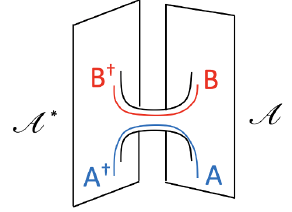
Figure 1 . Sketch of the topology of the wormhole we will consider. The two sides are setting up the computation of A and A ∗